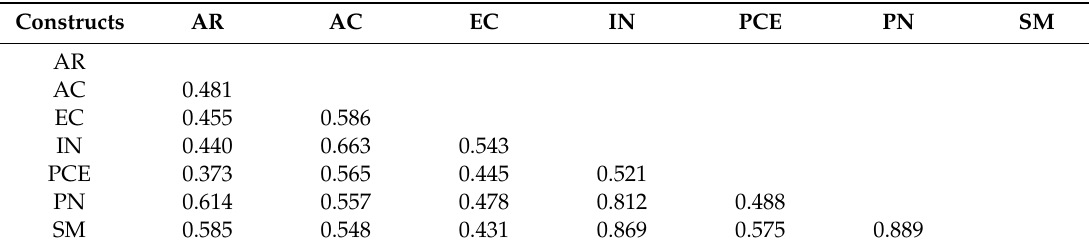
Table 3. Discriminant validity Heterotrait–Monotrait (HTMT) table.